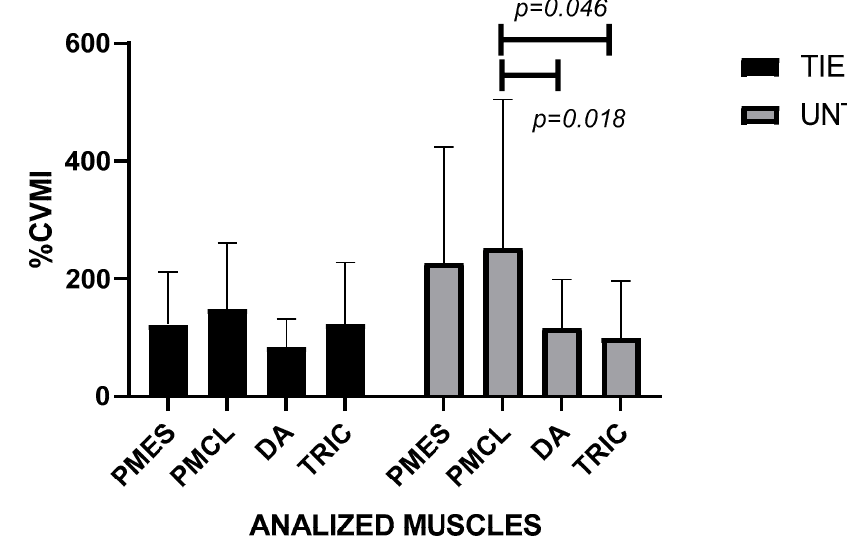
Figure 3. Muscle activation with a relative load of 60% 1RM in conditions untied and tied with leg/bench straps in paralympic powerlifting athletes. Legend: PMES = Pectoralis Major sternal portion; PMCL = Pectoralis Major clavicular portion; DA = Anterior deltoid; TRIC = triceps brachii.